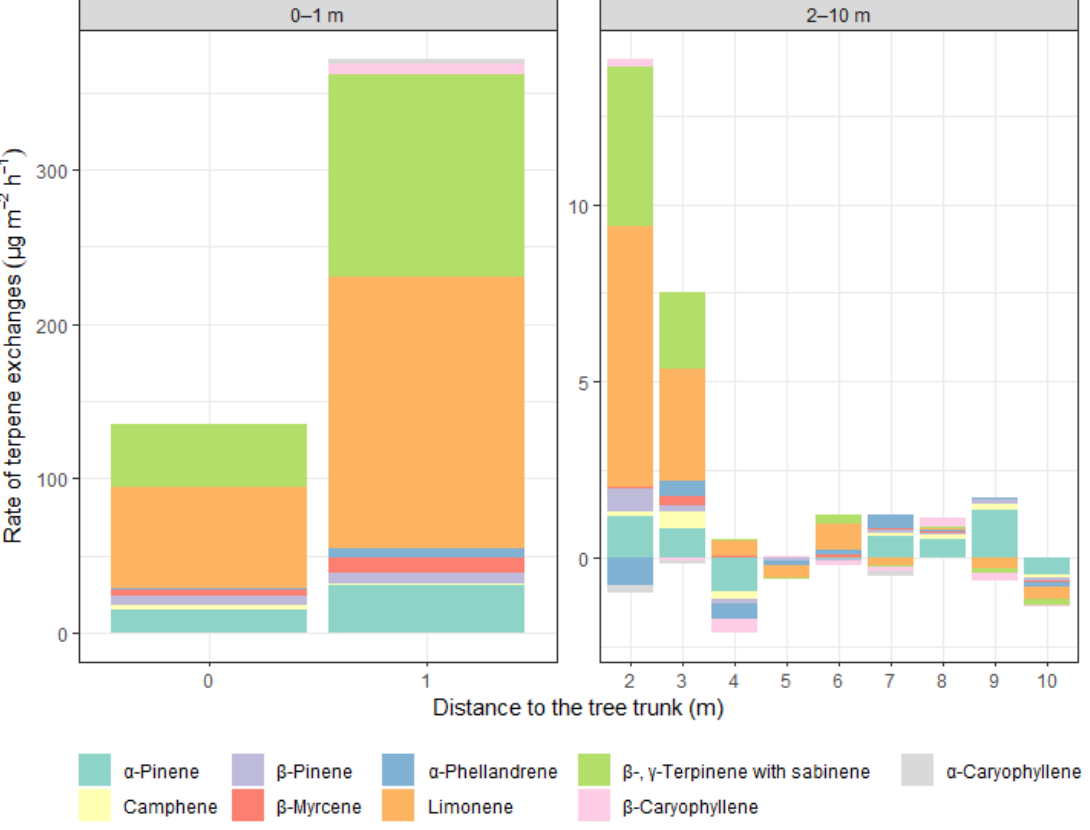
Figure 2. Distribution of terpene exchange along the transects.